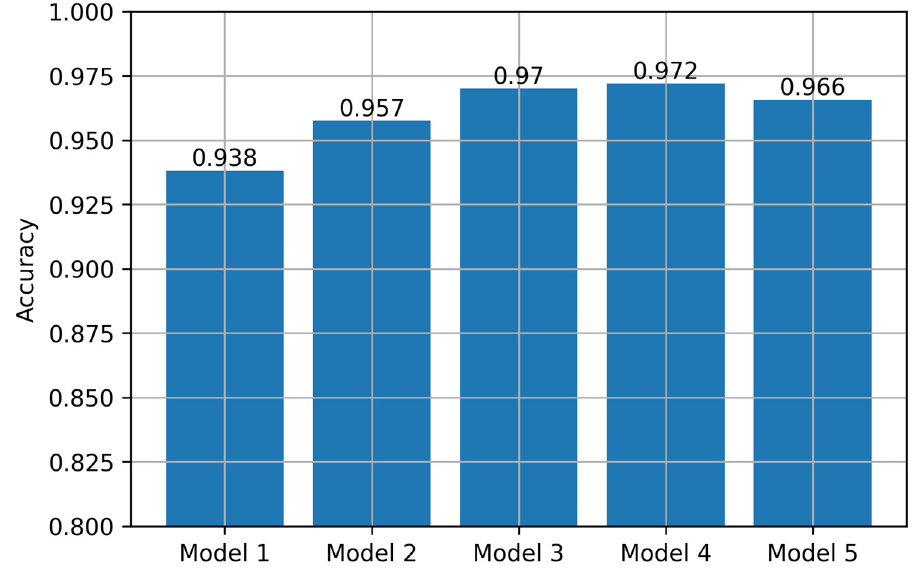
Figure 15. Accuracy of VGG19models with data augmentation.